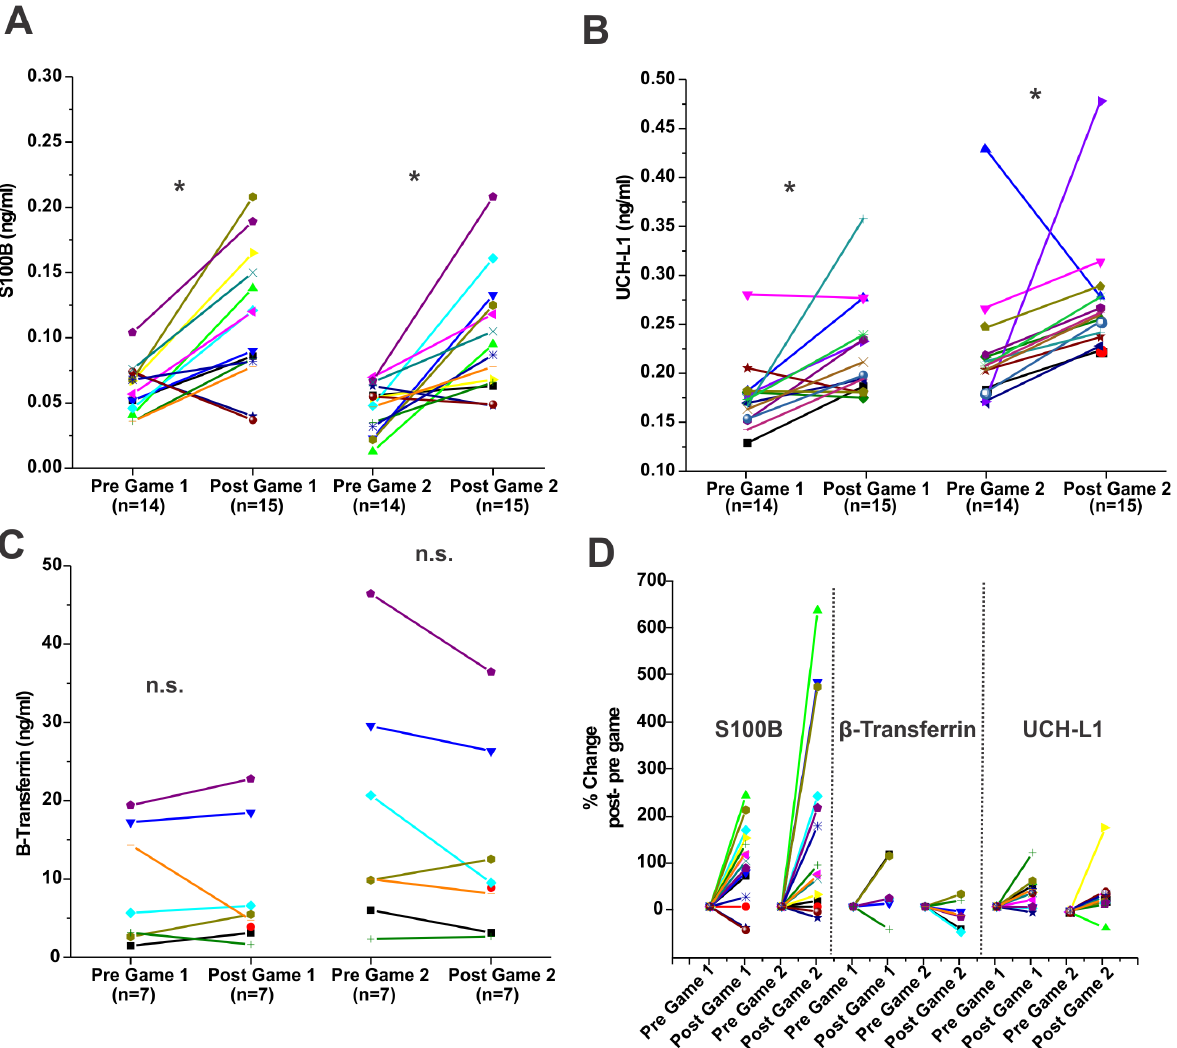
Figure 1. Pattern of S100B, UCH-L1 and b -2 transferrin changes in players after football games . Serum samples were drawn as described in the Methods. A total of 15 players were enrolled and analysis of samples reported here refers to two games played during the regular season. A ) , B ) and C ) refer to absolute S100B, UCH-L1 and b -2 transferrin serum levels respectively. Serum levels were measured pre- (day before the game) and post-games (within one hour from the end of a game). In D ) the normalized S100B, UCH-L1 and b -2 transferrin serum levels are shown side by side